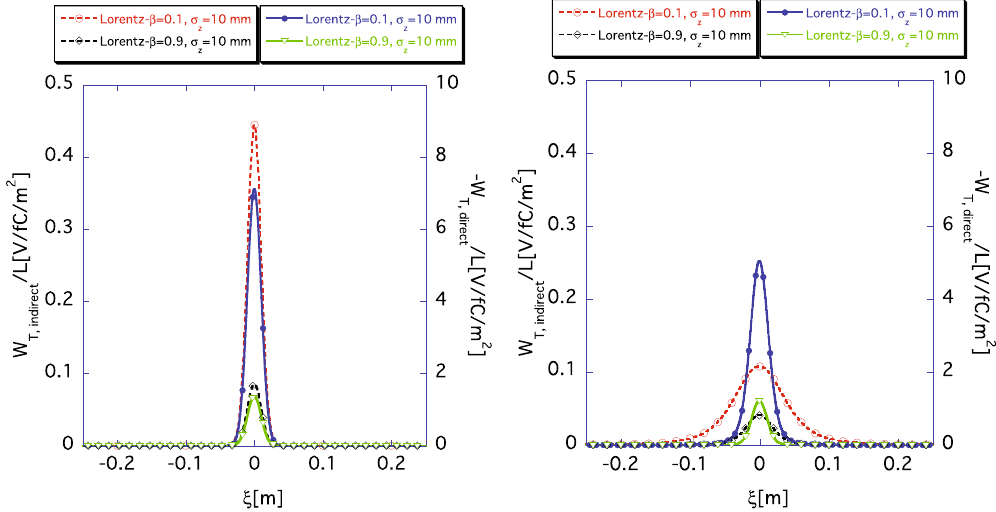
Figure 8. Approximate (left) result obtained using Eqs (77) and (78) and the exact (right) results obtained using Eqs (24) and (25) of the indirect wake function W T , indirect ( ξ ) and the direct wake function W T , direct ( ξ ) for σ z = 10 mm, where r b = 10 mm and a = 40 mm. The indirect wake function W T , indirect ( ξ ) (dashed) and the direct wake function (solid) W T , direct ( ξ ) are read using the scale markings on the left and the right vertical axes, respectively. The purple and red lines show the wake functions for β = 0.1 m and the green and black lines for β = 0.9 m,